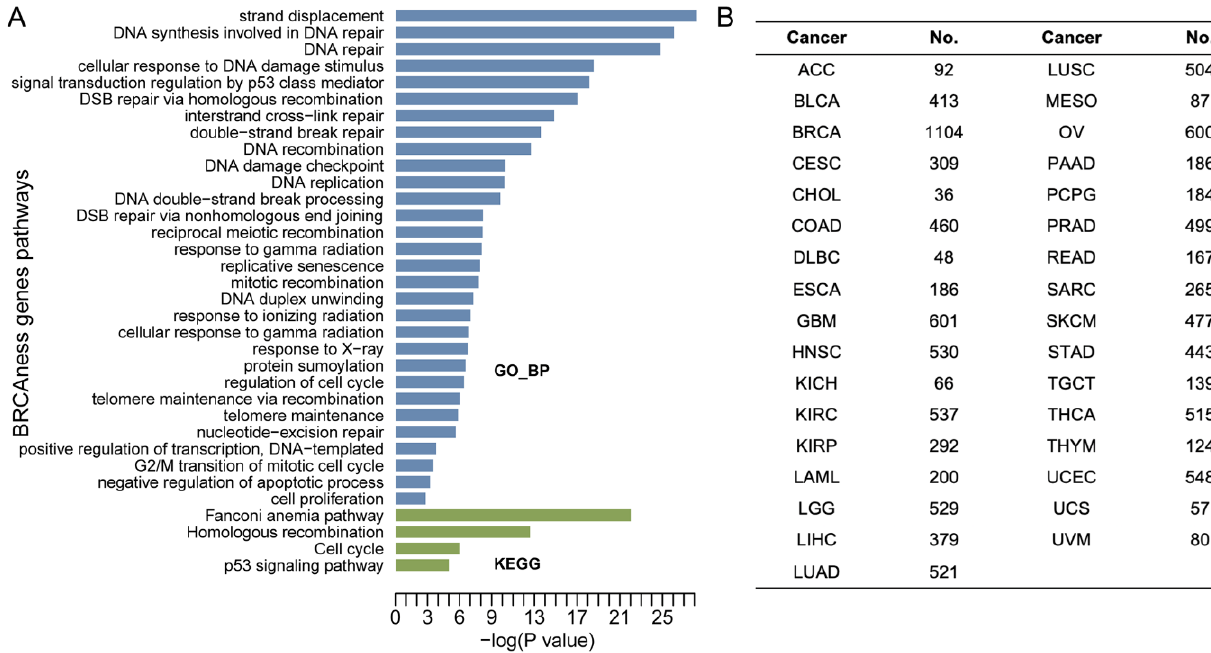
Table S1) by focusing on six characters: pathogenic variation, CNV, homozygosity, DNA methylation and gene expression, and clinical prognosis. In each analysis, BRCA1/2 status was used as gene-level controls, and BRCA1/2 mutated-breast and ovarian cancer were used as the cancer type-level controls.